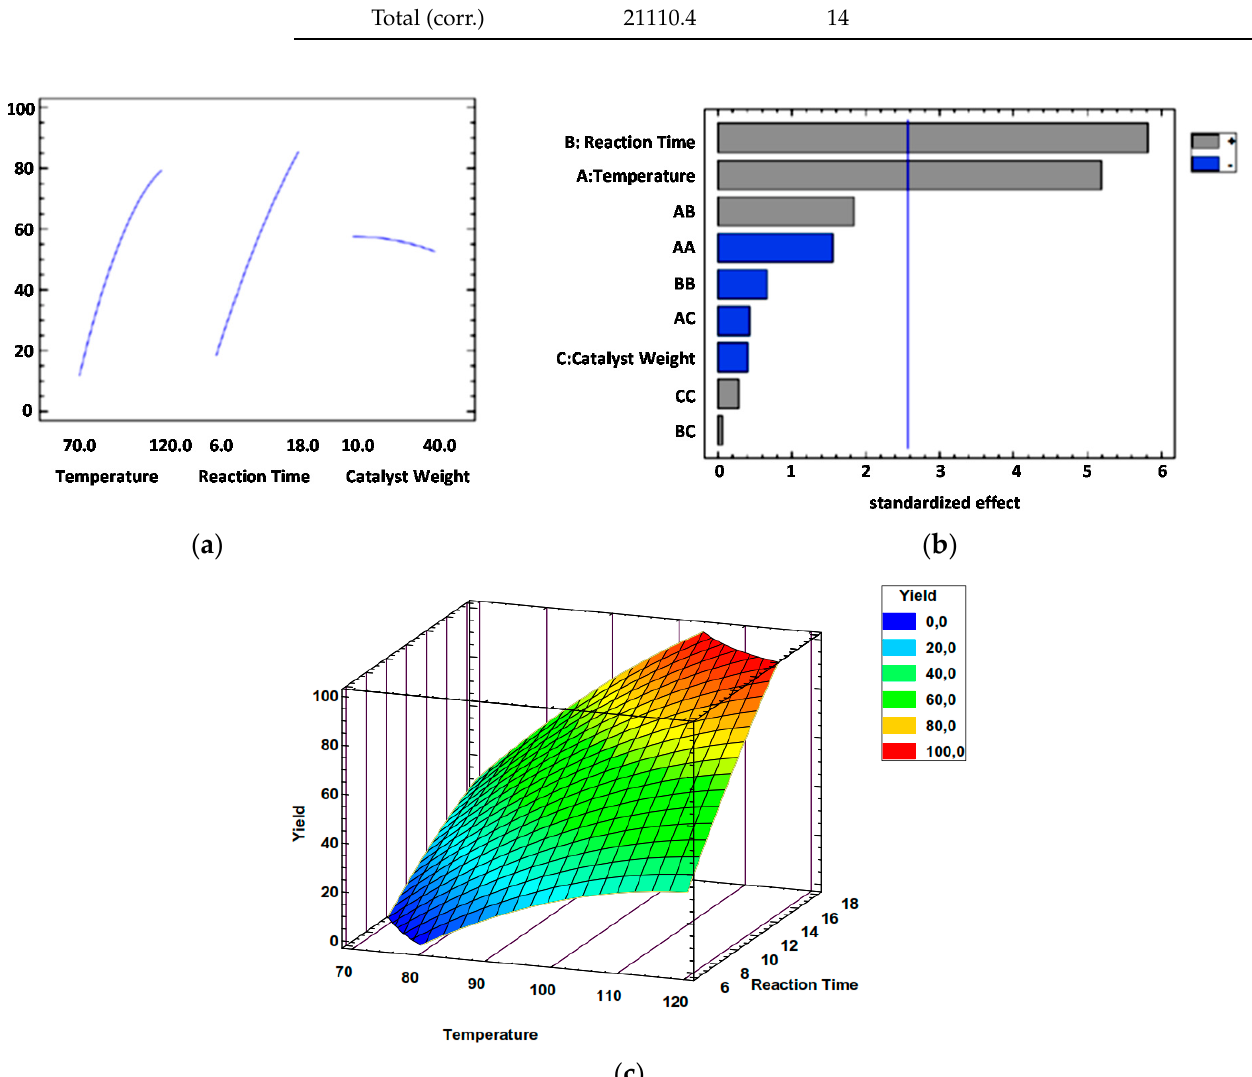
Figure 5. ( a ) Main effect plots for reaction yield, ( b ) standardized Pareto chart, and ( c ) response surface graph (catalyst weight 25 mg) of DOE method applied to steel slag catalytic performances.